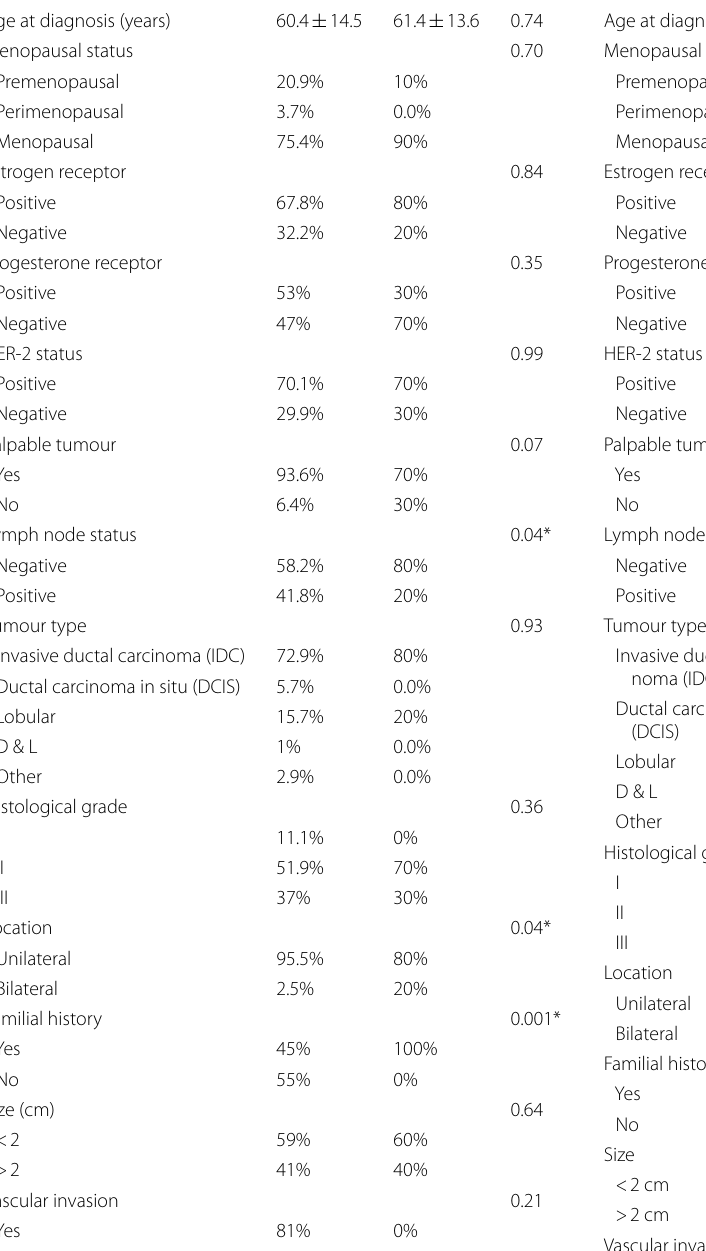
Table 3 Description of phenotypic characteristics of 35 out of 222 patients on which E2F1 expression and copy number